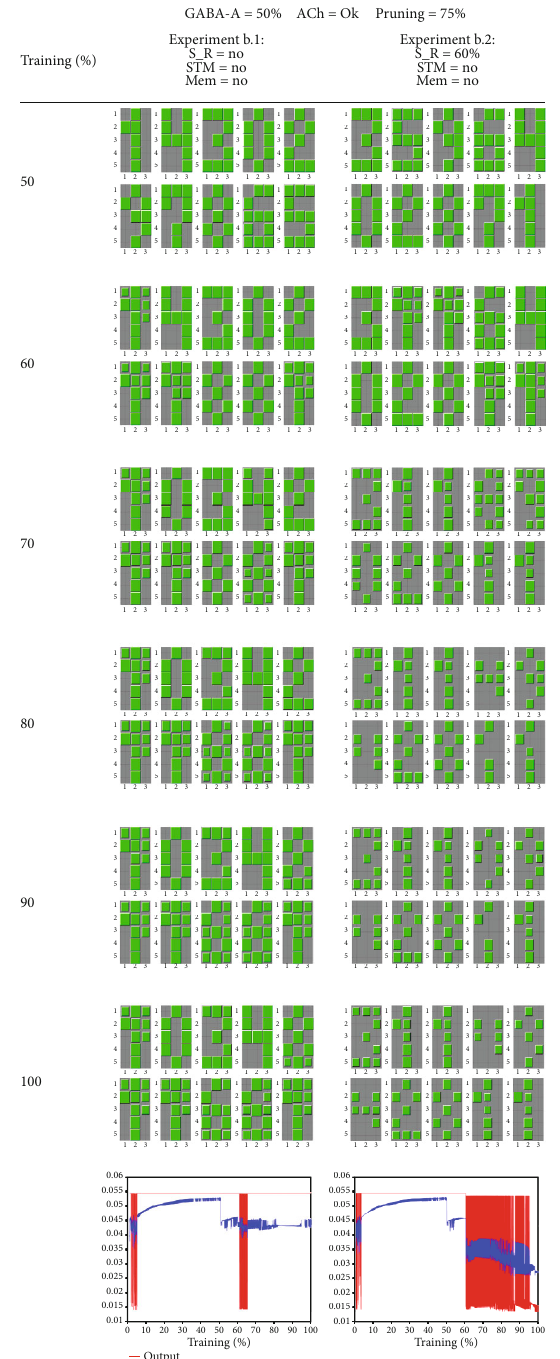
Figure 7: This table shows two cases without GABA-A signaling: the column on the left without sensory reduction and the column on the right with sensory reduction. At the bottom of each column, we show the evolution of the average output (in red) and average shift (in blue) of all neurons. Labels: S_R =sensory reduction; STM=short-term memory; Mem =memantine; ACh =acetylcholine reduction in thalamocortical neurons. In experiment b.1 (left column), there is no reduction of stimuli, and we see that, although an episodic period of acute output oscillations occurred, homeostatic mechanisms are capable of driving the network to equilibrium again. By examining the blocks, we see that pattern recall was permanently impaired. However, acute oscillations related to hypermetabolism and disease progression were extinguished. In experiment b.2, the withdrawal of GABA-A at 50% of epochs was the precondition for the production of intense oscillations when the sensory reduction took place at 60% of epochs. At the same time, at 60% of epochs, neurons lost their pattern speci fi city so that several neurons processed the same pattern (number 1). Sustained oscillations are associated with hypermetabolism and the progression of